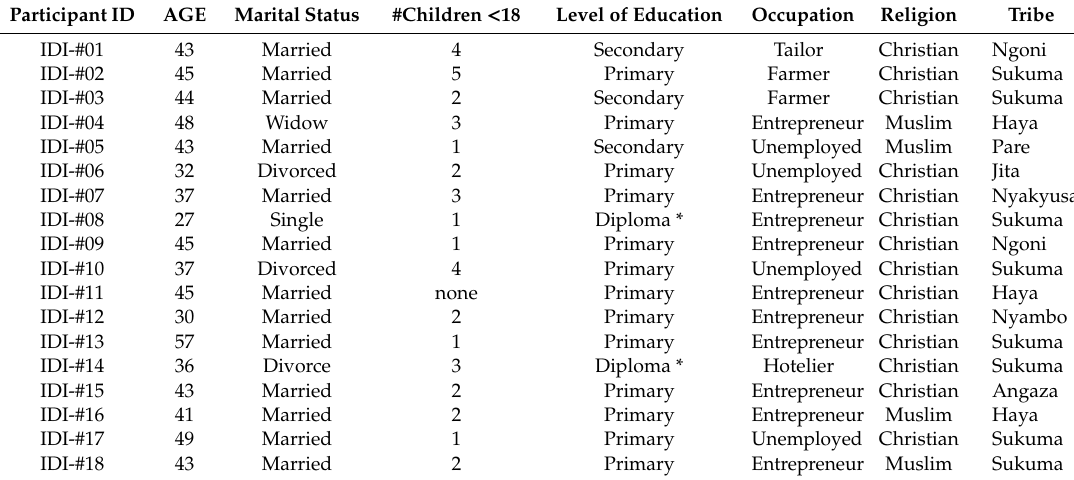
Table 1. Characteristics of the study